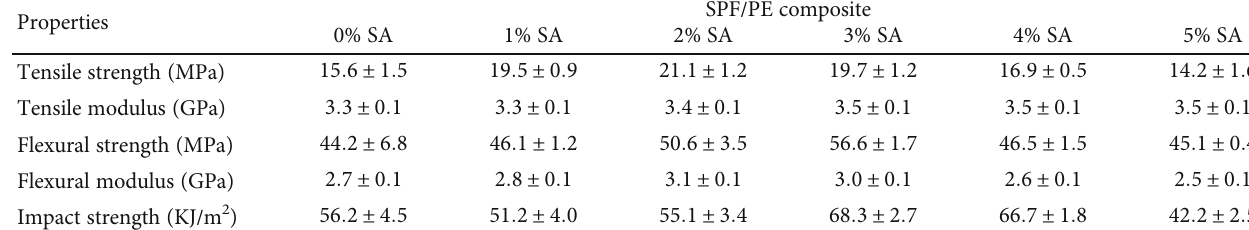
Table 2: Mechanical properties of SPF/PE with and without SA.